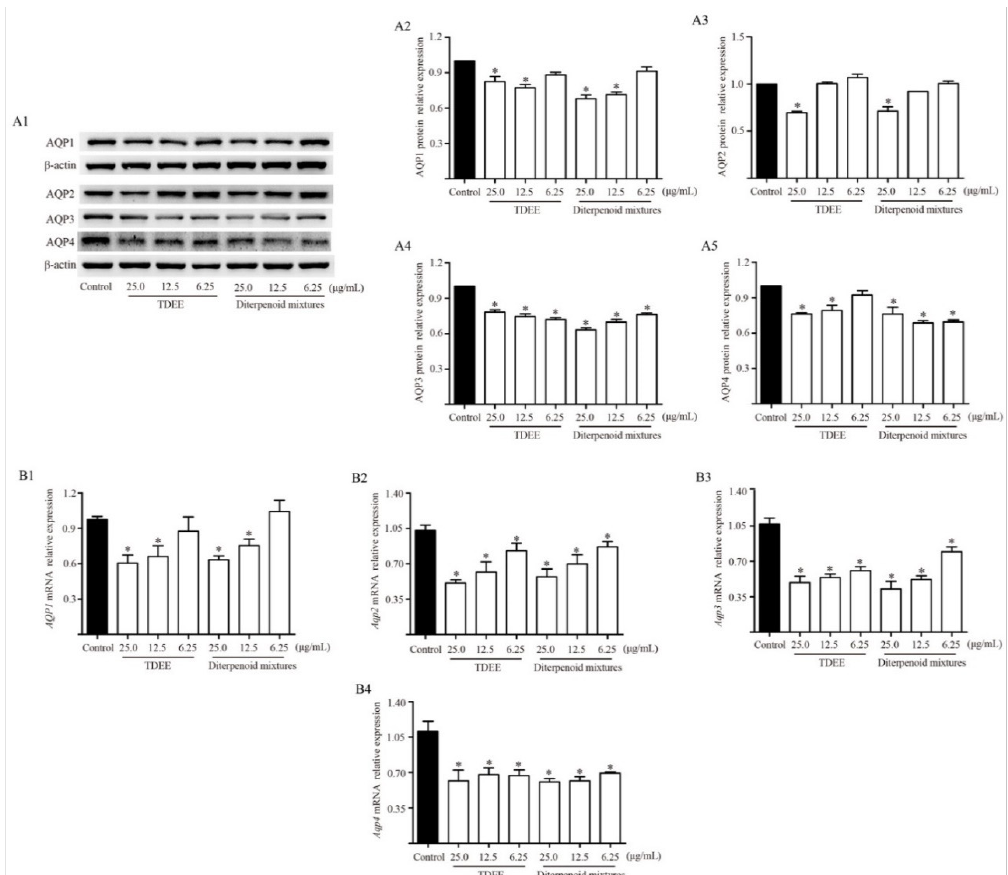
Figure 7. Effects of total diterpenoids from the root of Euphorbia ebracteolata Hayata (TDEE) and six diterpenoids mixtures on the protein and mRNA expression levels of aquaporin (AQP)-1 in human kidney-2 cells (HK-2), and AQP2, AQP3 and AQP4 in murine inner medullary collecting duct cells (mIMCD3). ( A1 – A5 ) Western blot bands and protein relative expression of AQP1, AQP2, AQP3 and AQP4. ( B1 – B4 ) mRNA relative expression of AQP1 , Aqp2 , Aqp3 and Aqp4 . The data are represented as the mean ± SD, n = 3, * p < 0.05 vs. control group (Mann–Whitney U test). Diterpenoids mixture was mixed according to the contents of six diterpenoids in